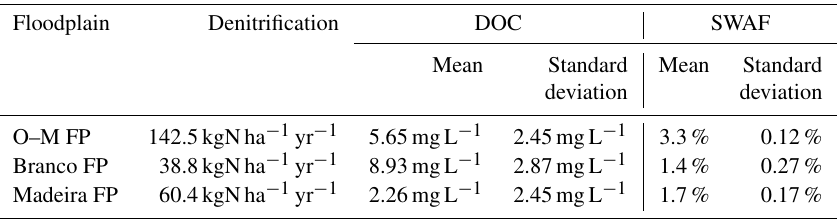
Table 3. Overall denitrification (kgNha − 1 yr − 1 ) and mean and standard deviation of the SWAF and DOC (mgL − 1 ) values for the three